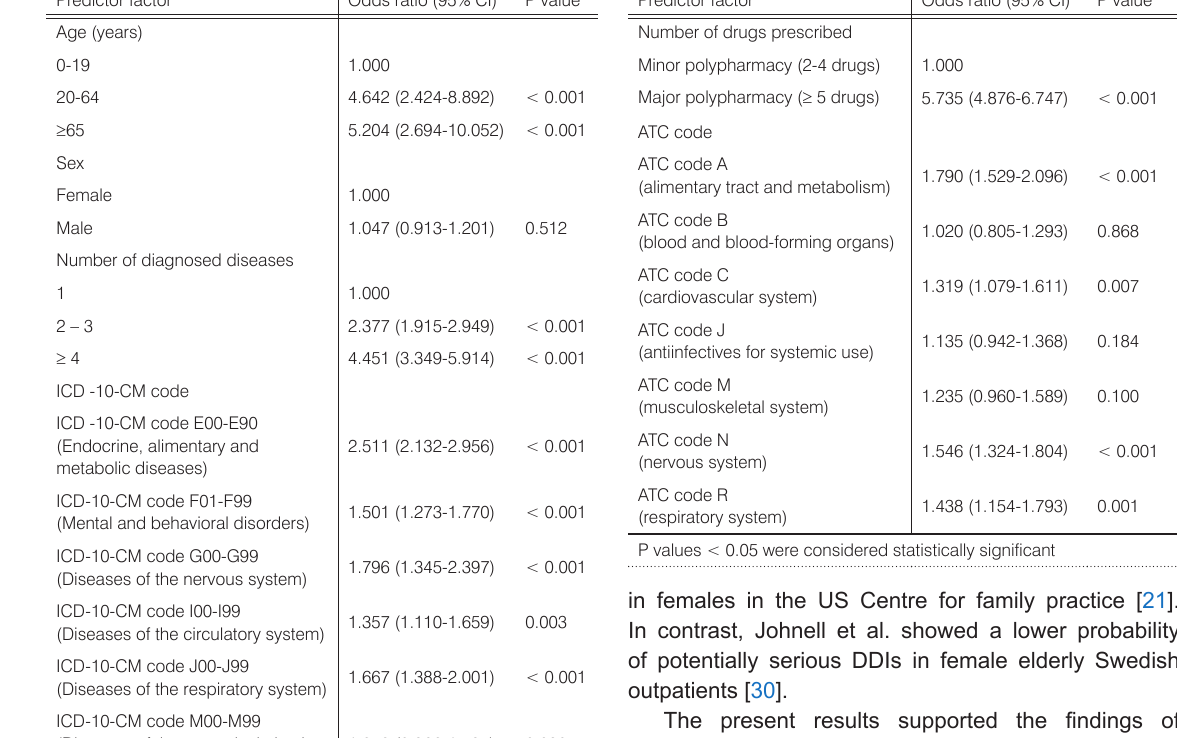
Table 3. Patient characteristics associated with clinical significant potential drug-drug interactions Predictor factor